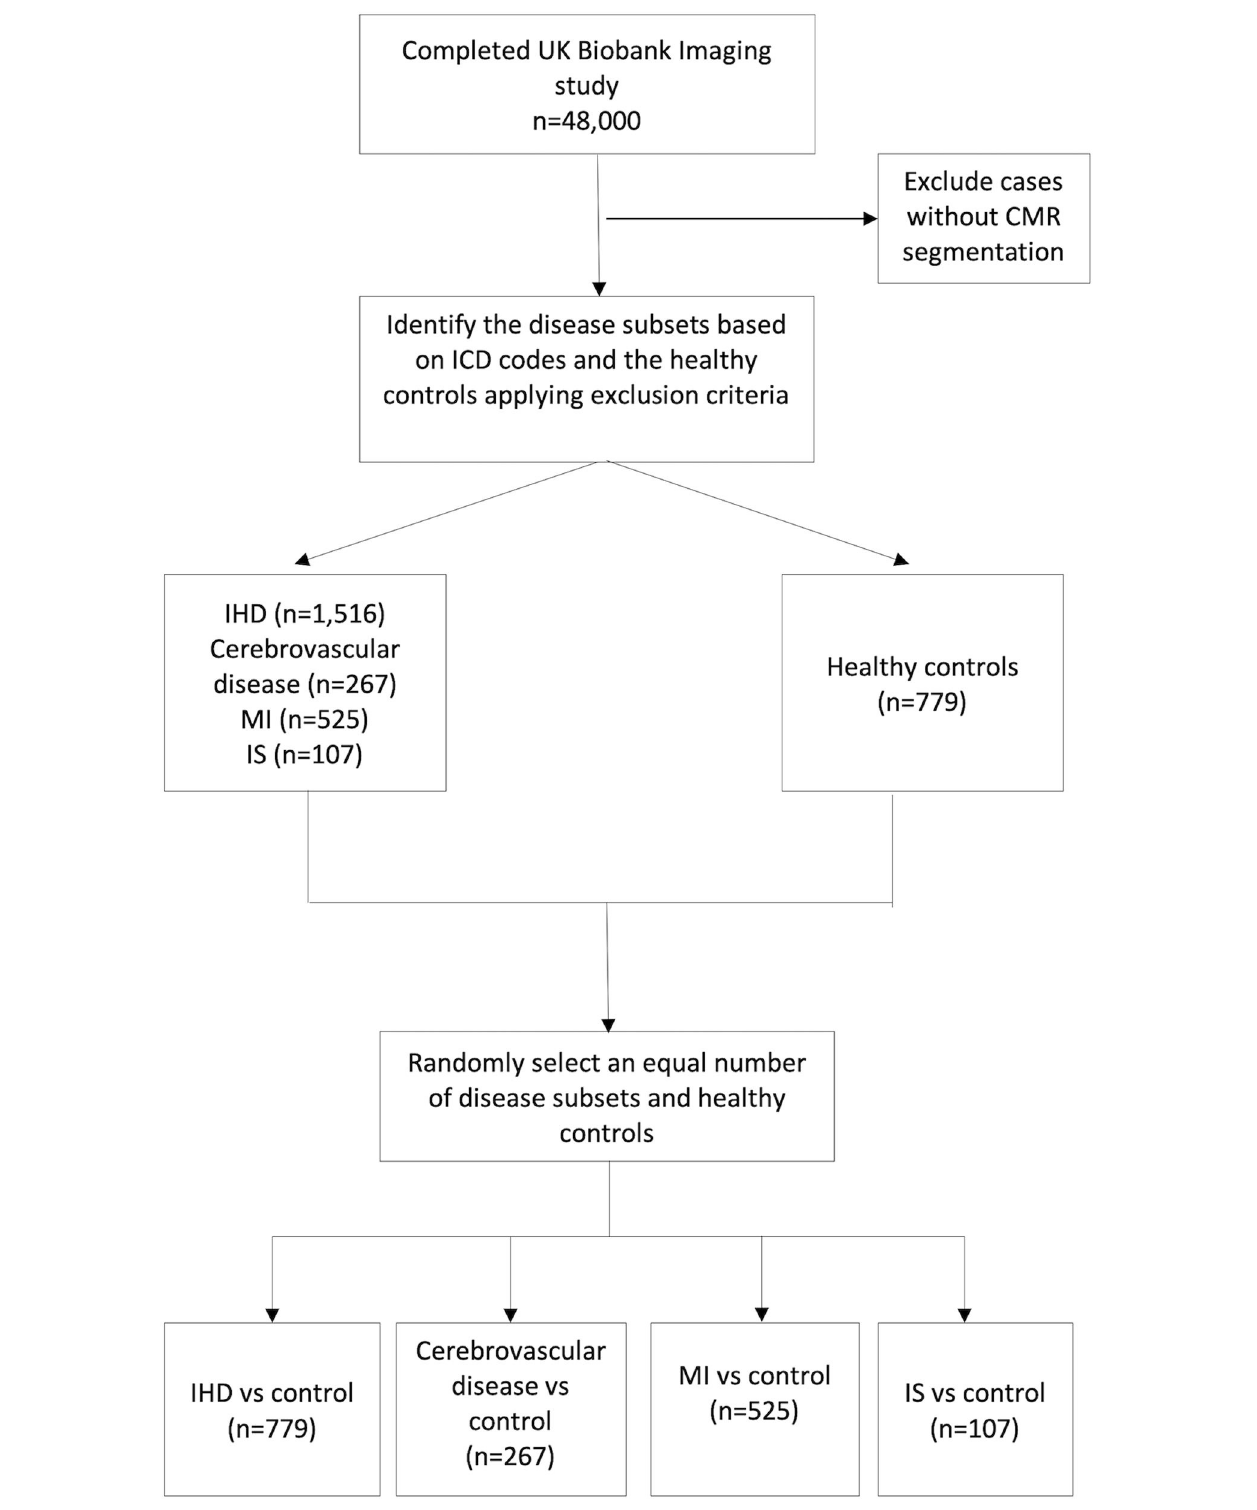
FIGURE 1 | Study cohorts selection process. IHD, Ischaemic heart disease; MI, myocardial infarction; IS, ischaemic stroke.